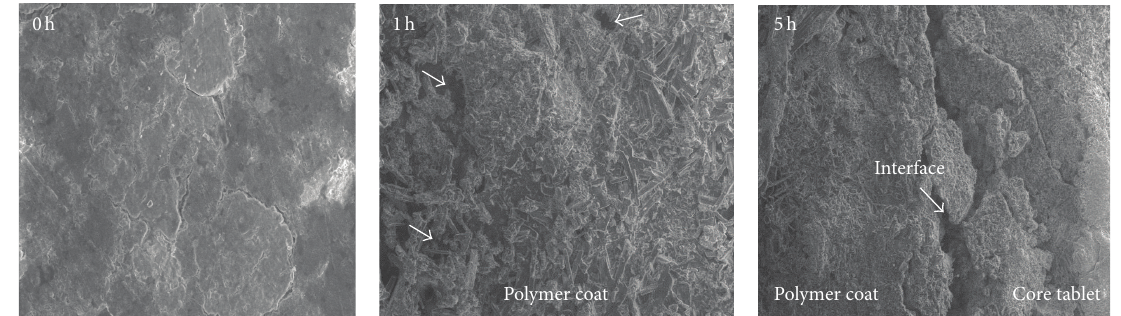
Figure 5: SEM images of optimized formulation FP 14 at magnification of